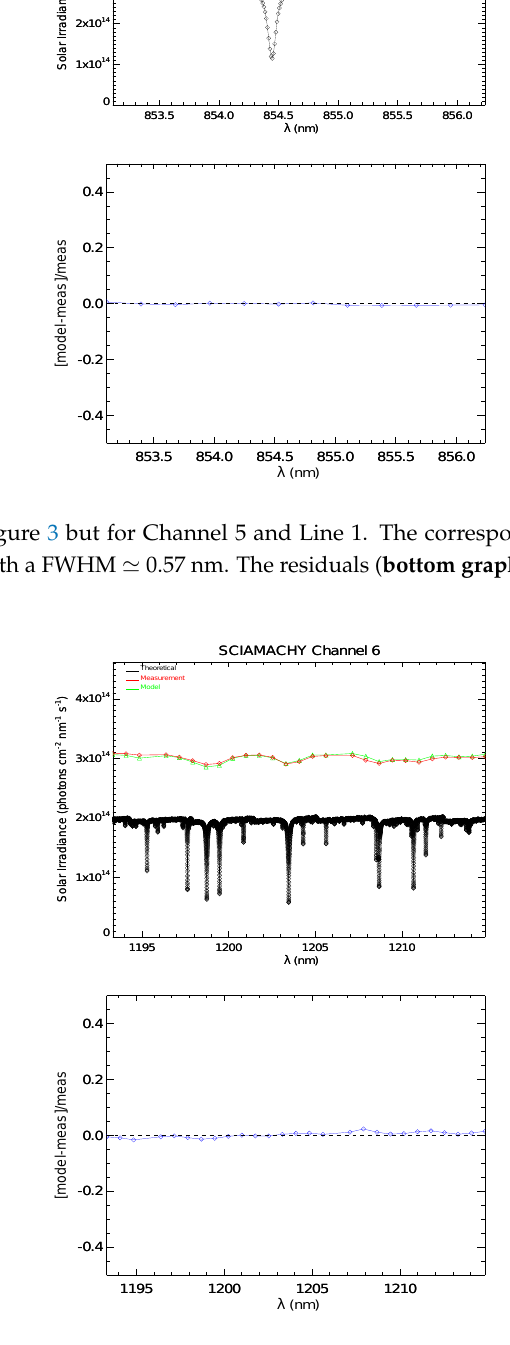
Figure 8. Similar to Figure 3 but for Channel 6 and Line 1. The theoretical spectrum ( top ) black curve was lowered here on purpose, it would otherwise hide the model and measurement curves. The corresponding retrieved ISRF is a Hyperbolic function with a FWHM (cid:39) 1.47 nm. The residuals ( bottom graph ) rms (cid:39)